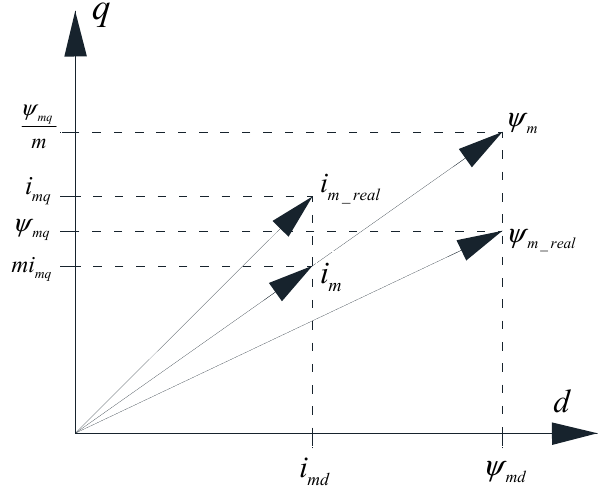
Figure 3. Space vectors of the magnetizing current and magnetizing flux (and their components) of an anisotropic and of an equivalent isotropic machine.